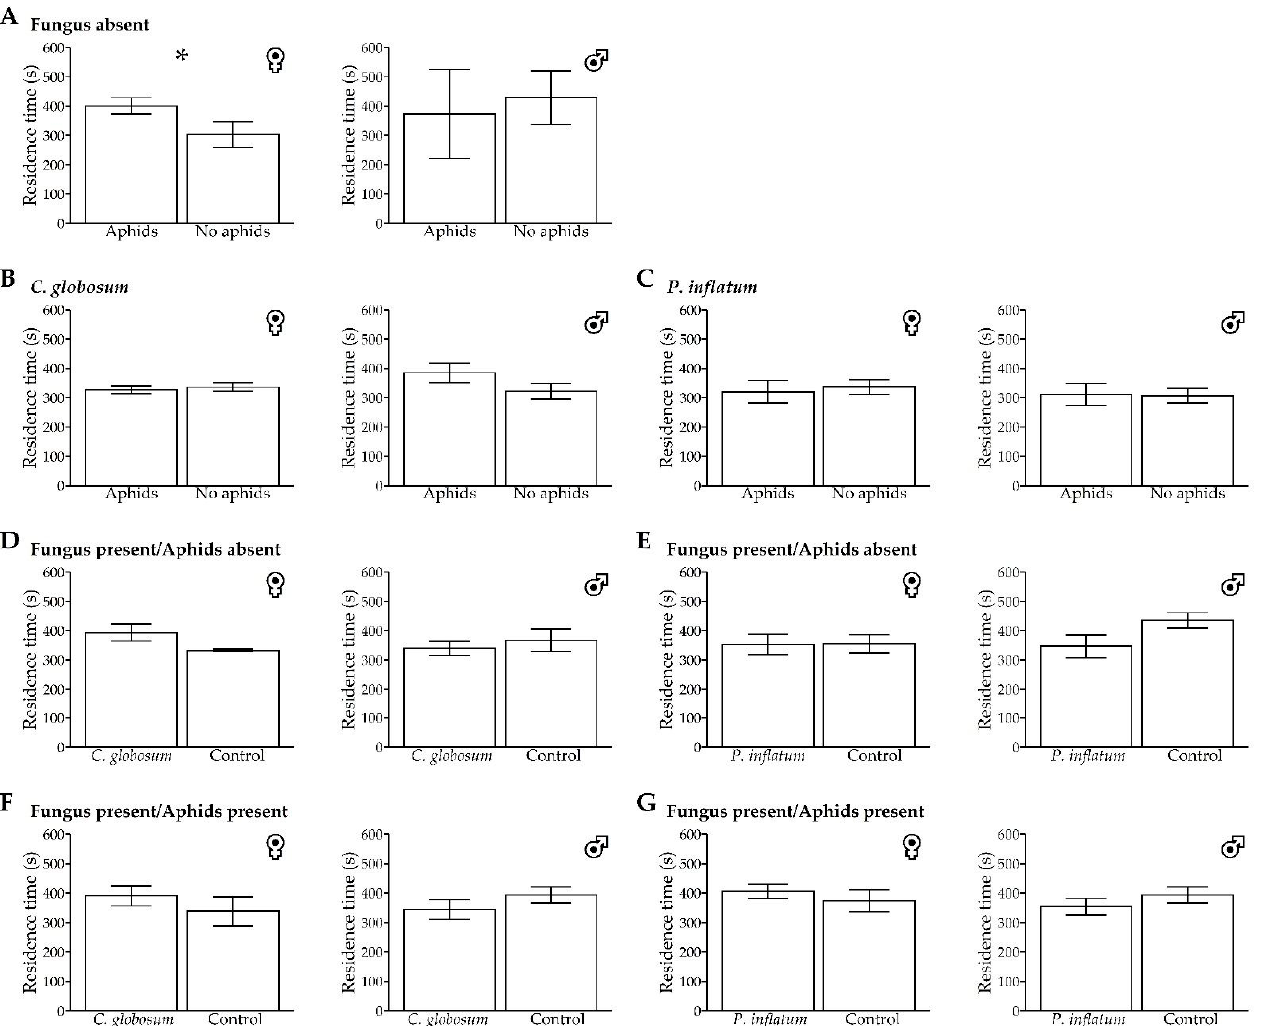
Figure 4. Means ( ± SE) of Hippodamia convergens female and male residence times (seconds) associated with olfactory stimuli emitted from untreated control and fungal-treated ( Chaetomium globosum and Phialemonium inflatum ) cotton plants in a dual-choice Y-tube olfactometer. ( A – C ) Untreated plants, C. globosum, and P. inflatum treated plants with aphids vs. no aphids, respectively. ( D , E ) Fungal-treated plants vs. untreated plants, both without aphids. ( F , G ) Fungal-treated plants vs. untreated plants, both with aphids. Each individual had 600 s (10 min) to stay in the Y-tube arm, and the beetles that did not respond were not included in the analysis. * p < 0.05 (Welch’s two-sample t -test).